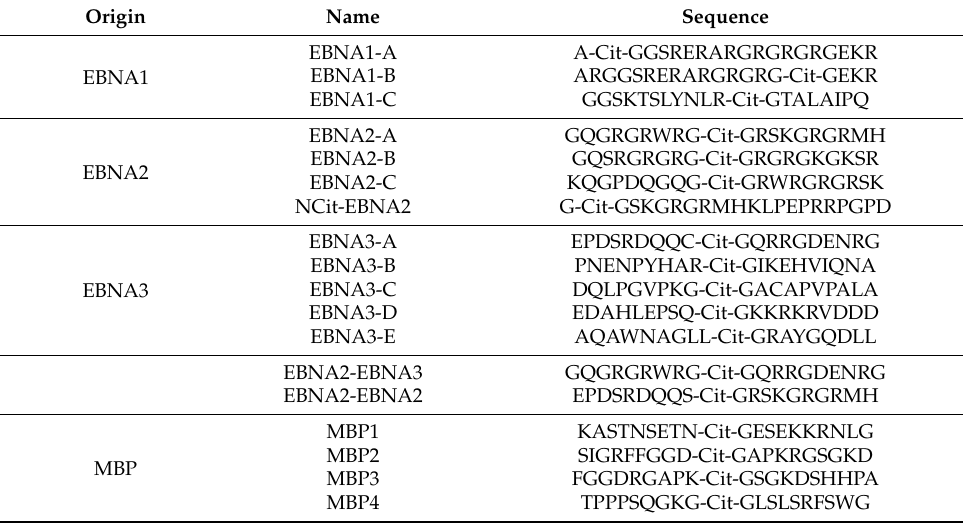
Table 1. Synthetic citrullinated peptides tested for antibody